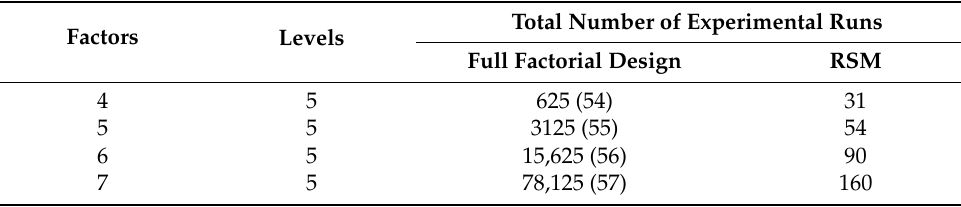
Table 1. Total number of experimental runs for full factorial design and response surface methodology (RSM) based on five-level factors.